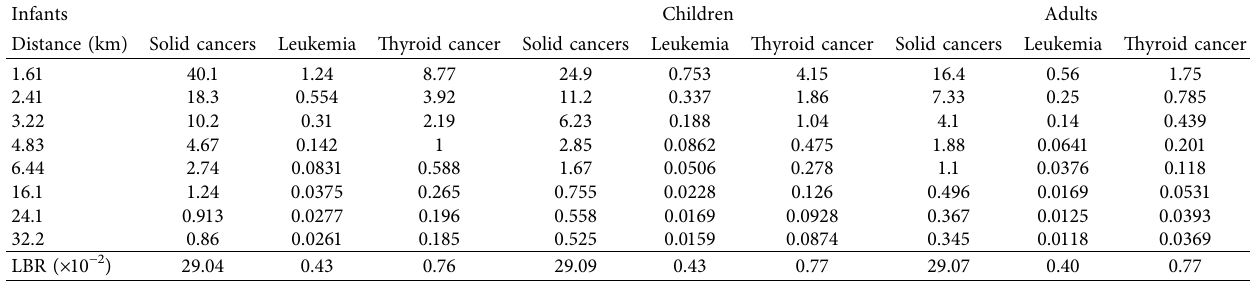
Table 2: LAR (10 − 2 ) of females per 100,000 exposed persons.